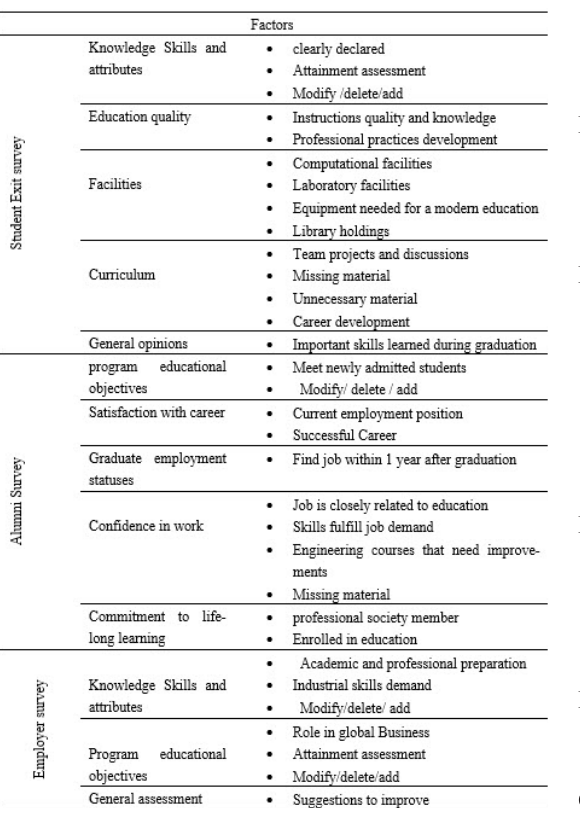
Table 11. Student exit, Alumni and Em- ployer